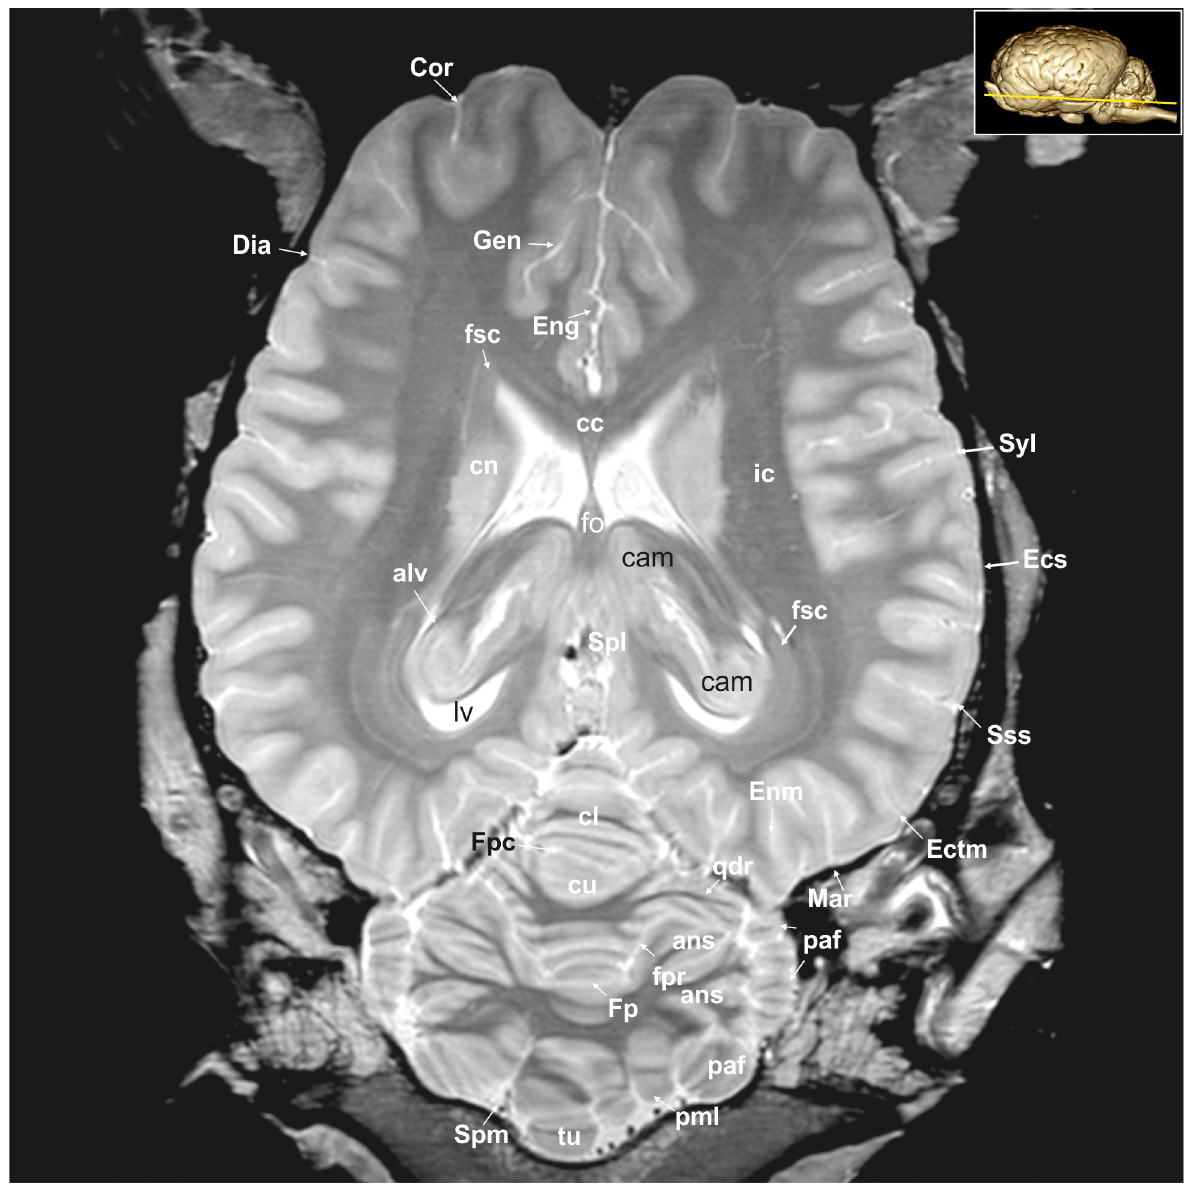
Fig 23. Dorsal magnetic resonance image of the equine brain on the level of the pineal gland. alv: alveus, ans: ansiform lobule, cam: ammon’s horn, cc: corpus callosum, cl: central lobule, cn: caudate nucleus, Cor: coronal sulcus, cu: culmen, Dia: diagonal sulcus, Ecs: ectosylvian sulcus, Ectm: ectomarginal sulcus, Eng: endogenual sulcus, Enm: endomarginal sulcus, fo: fornix, Fp: primary fissure, fpaf: paraflocculare fissure, Fpc: praeculminate fissure, fsc: subcallosal fasciculus, Gen: genual sulcus, ic: internal capsule, lv: lateral ventricle, Mar: marginal sulcus, paf: paraflocculus, pml: paramedian lobule, qdr: quadrangulare lobule, Spl: splenial sulcus, Spm: paramedian sulcus, Sss: suprasylvian sulcus, Syl: sylvian fissure, tu: tuber of the vermis.